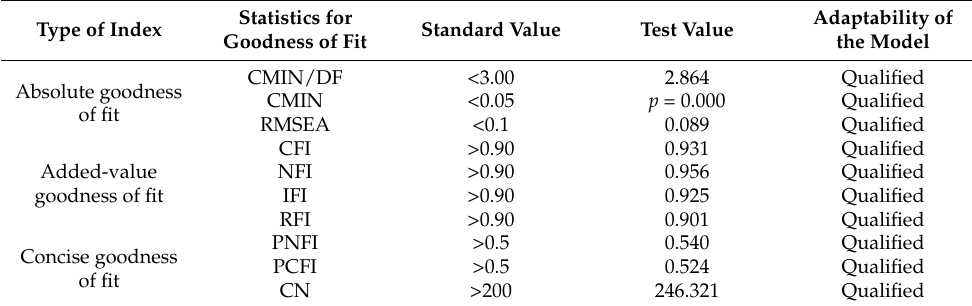
Table 2. Model goodness-of-fit index.